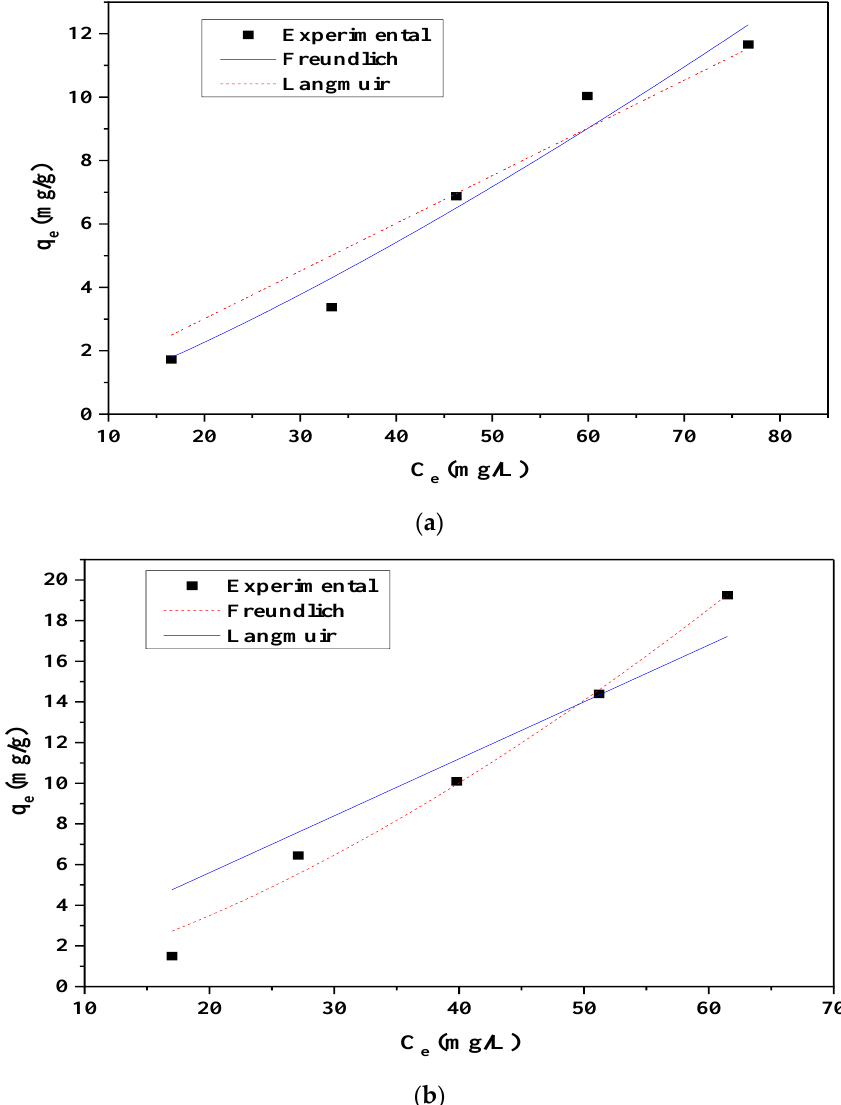
Figure 5. Fit to isothermal non-linear models of adsorption equilibrium experimental data of ( a ) nitrate and ( b ) phosphate using modified cellulose (MC) as adsorbent.